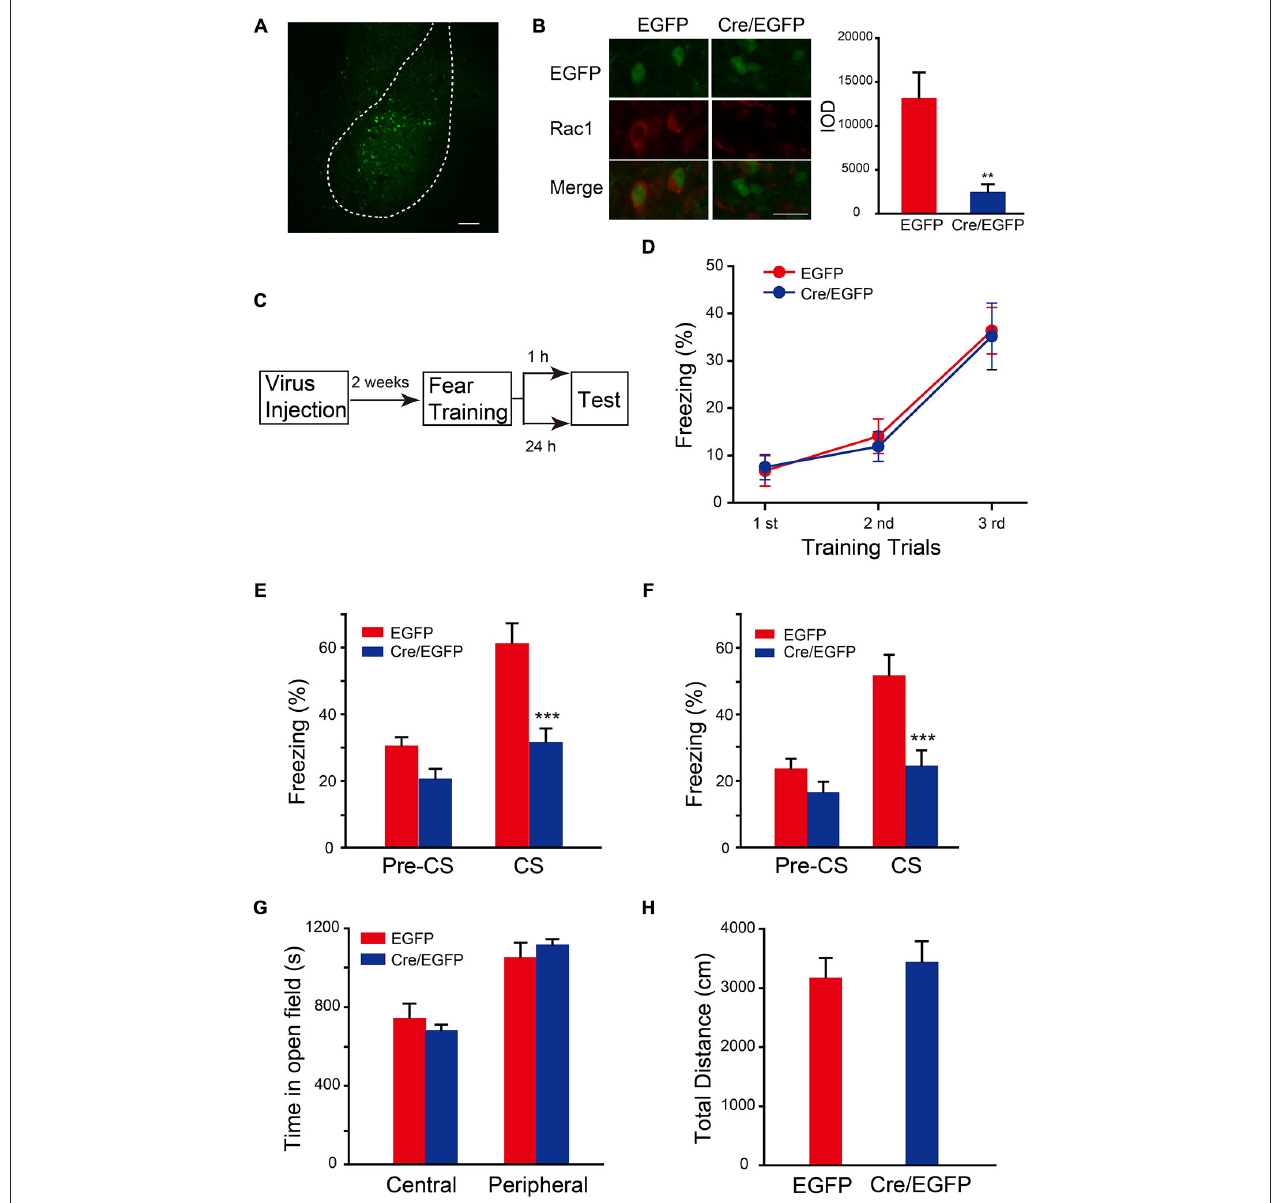
FIGURE 2 | Conditional knock out of Rac1 in BLA disrupted STM and LTM of fear conditioning. (A) Fluorescence image of AAV infected BLA. Scale bar: 100 µ m. (B) Immunofluorescence staining of Rac1 (red) in BLA of Rac1 flox / flox mice infected with AAV and the quantification of integrated optical density (IOD) of Rac1 in EGFP positive cells ( n = 20 subjects each, ∗∗ p < 0.05). Scale bar: 20 µ m. (C) Experimental design. Two weeks after virus injection, mice were subjected to fear conditioning training followed by 1 h or 24 h memory test. (D) The freezing levels during each tone presentation in the training session (EGFP: n = 16, Cre/EGFP: n = 18). (E,F) Ablation of Rac1 in BLA decreased the freezing levels at 1 h ( E , EGFP: n = 8, Cre/EGFP: n = 11, ∗∗∗ p < 0.001) and 24 h ( F , EGFP: n = 8, Cre/EGFP: n = 9, ∗∗∗ p < 0.001) auditory fear memory tests. (G,H) The results of a 30 min locomotion test in an open-field apparatus (EGFP: n = 9, Cre/EGFP: n =